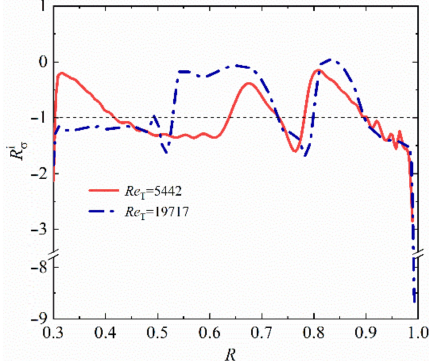
Figure 14. Snapshots of rotating waves ( top ) and STD at R = 0.65 ( bottom ) when Re c = 1871. ( a ) Re T = 5442; ( b ) Re T = 19,717.